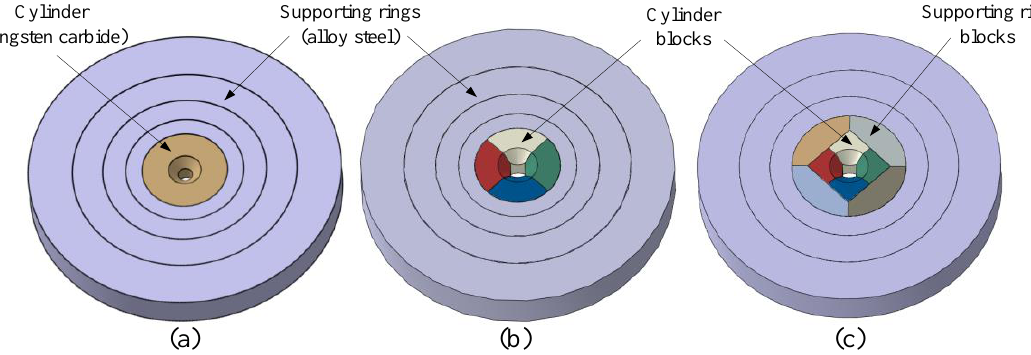
Figure 1. Schematic diagrams of high-pressure dies: ( a ) conventional belt-type die (BTD); ( b ) single-layered split die (SLSD); and ( c ) novel double-layered split die (DLSD).